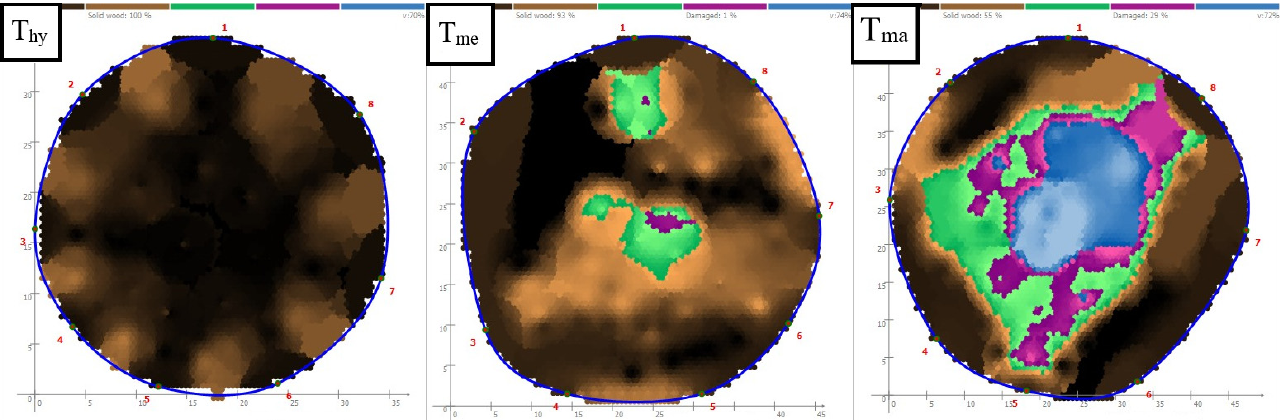
Figure 2. Examples of tomograph assessment classes (healthy tomogram T hy ; tomogram with medium defect T me ; and tomogram with major defect T ma ) The numbers around the tomogram (1–8) indicate the location of the measurement points.